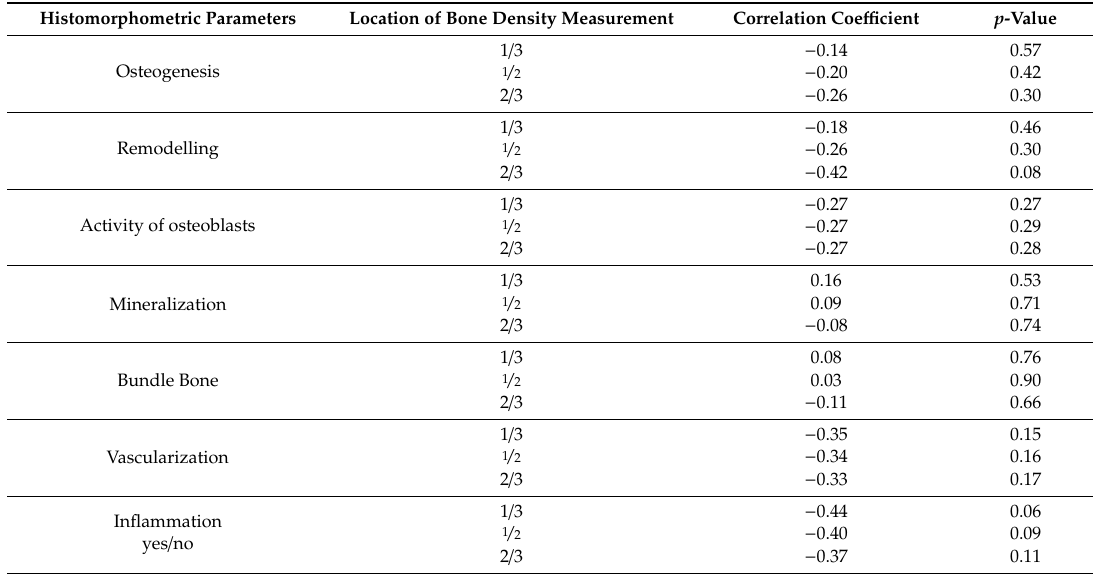
Table 4. Association between histomorphometric results and radiologically measured bone density as a function of measurement